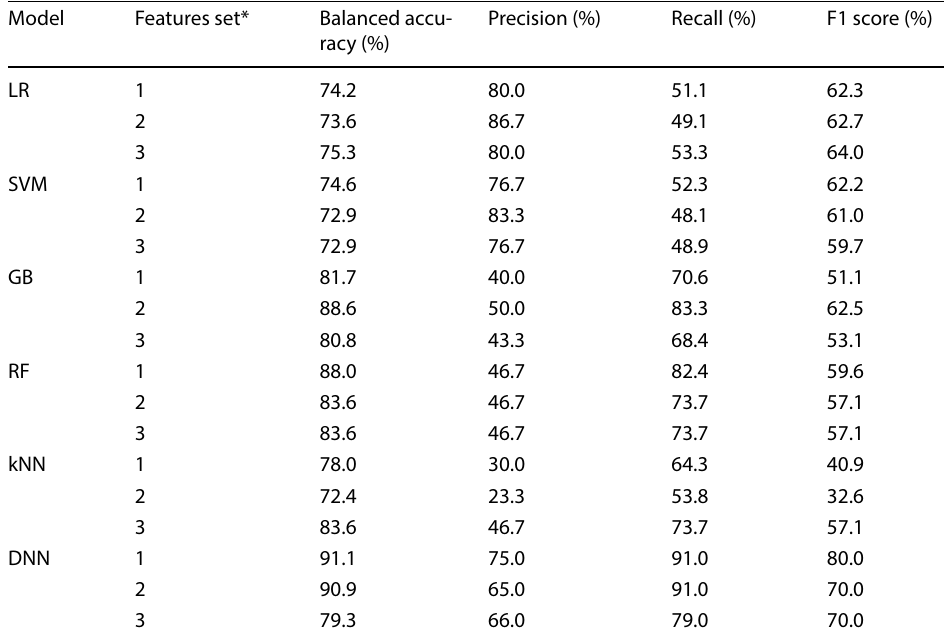
Table 2 ML models performances in CMM mortality risk prediction